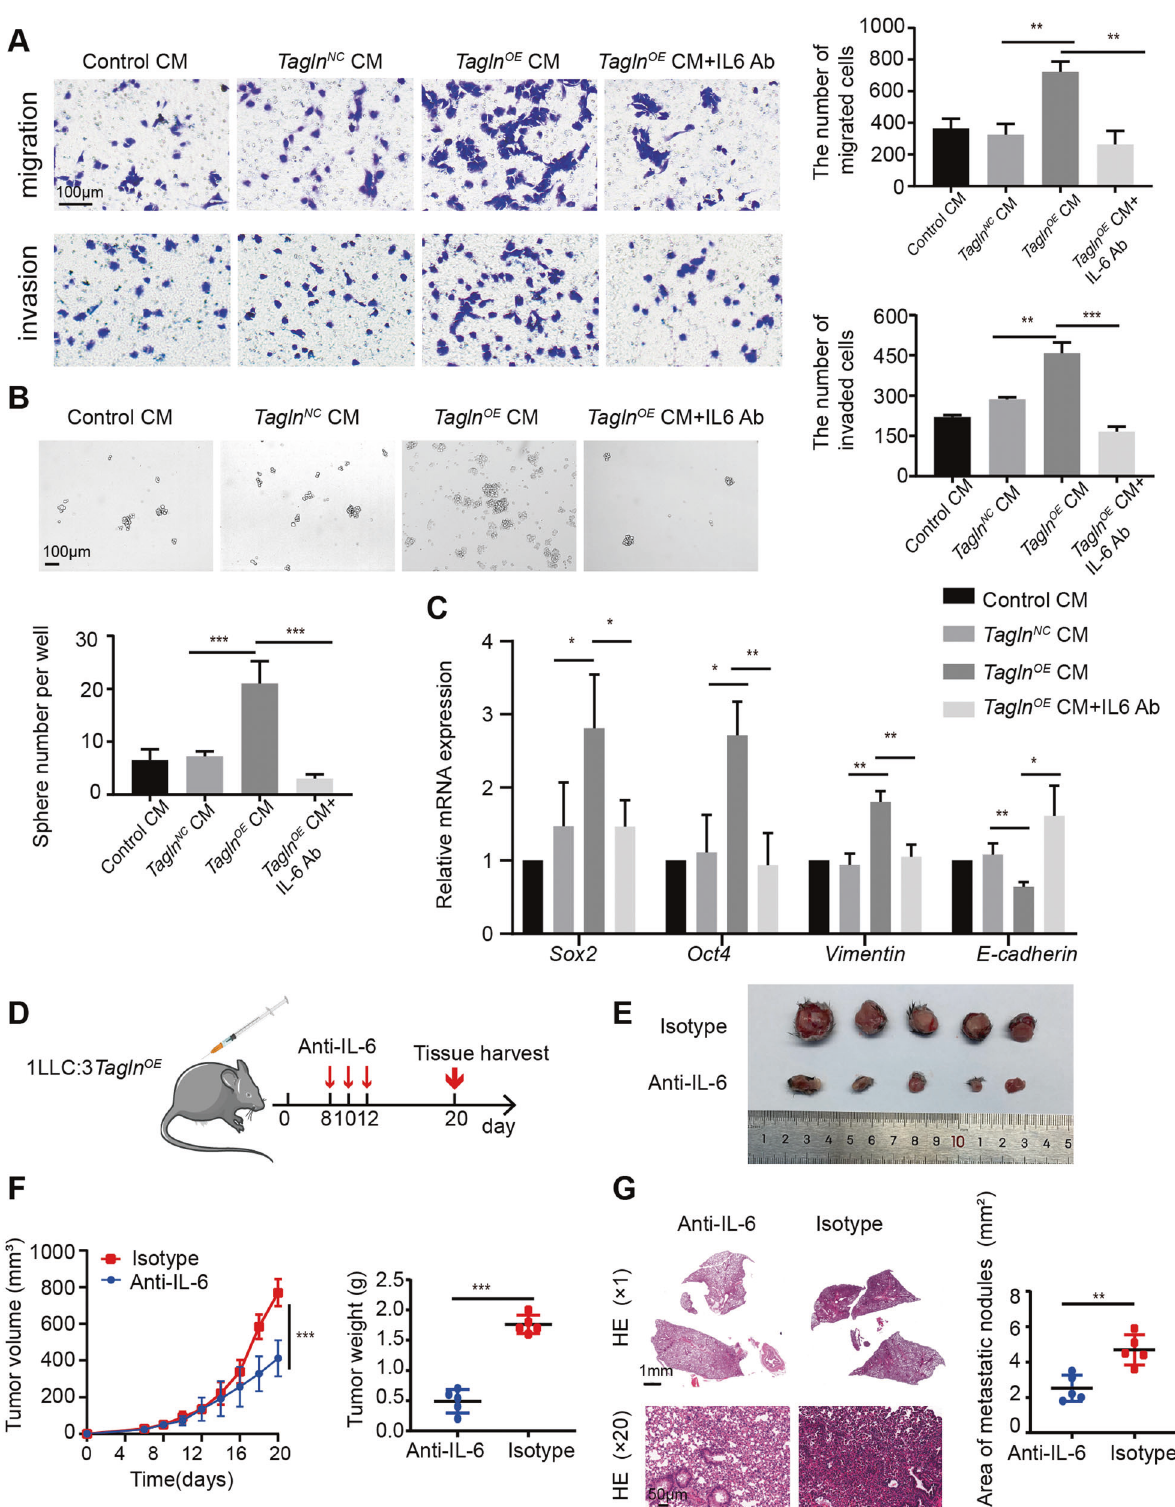
Fig. 7 IL-6 from Tagln OE iMEFs may promote the malignant phenotype of lung cancer cells. A Transwell assay was performed to determine the effects of IL-6 neutralizing antibody on migration and invasion properties of Lewis lung cancer cells (LLCs) fed with different conditioned media (CM). B Tumor sphere formation assay upon IL-6 neutralizing antibody treatment. C Quantitative RT-PCR analysis of mRNA levels of epithelial – mesenchymal transition-related proteins and cancer stem cell markers in LLCs fed with different CM, with or without IL-6 neutralizing antibodies. D Anti-IL-6-neutralizing antibody treatment in mice. E Photographs of tumors from mice. F Tumor volume and tumor weight ( n = 5). G Representative hematoxylin and eosin staining images and quanti fi cation data of lung metastasis in mice. Upper panel scale bar: 1 mm; lower panel scale bar: 50 µm. Data are represented as mean ± SEM from at least three independent experiments. *** p < 0.001; ** p < 0.01; * p <